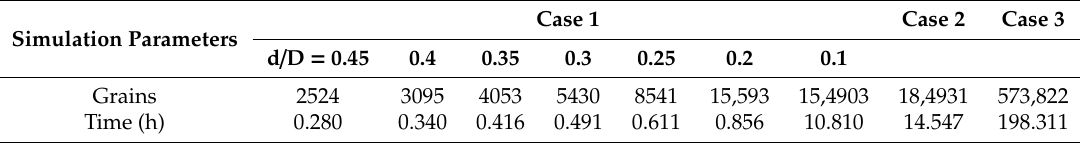
Table 5. Total time simulation and number of